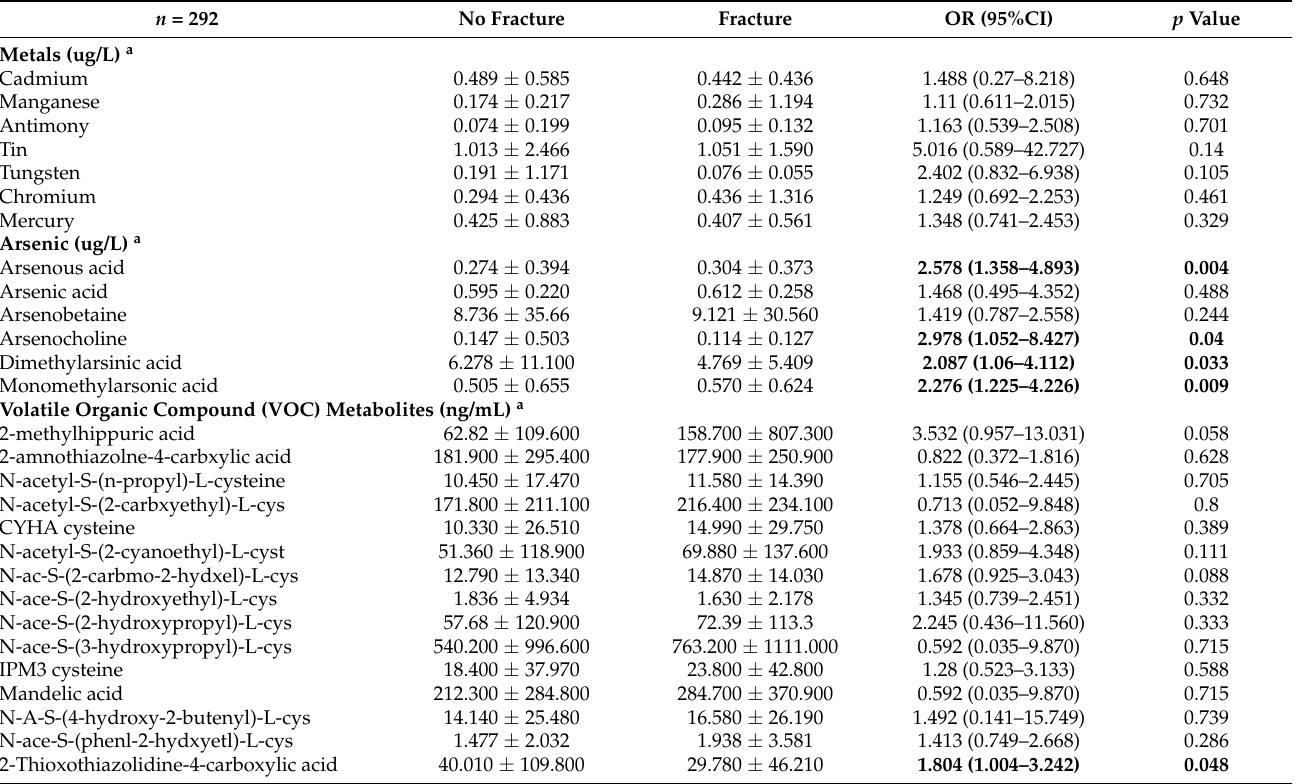
Table 4. Associations with multiple environmental chemical factors and fractures in